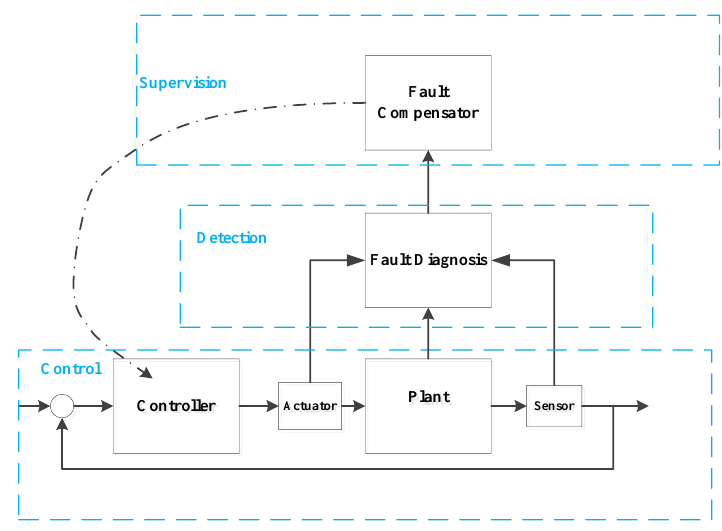
Figure 4. General Structure of active FTC